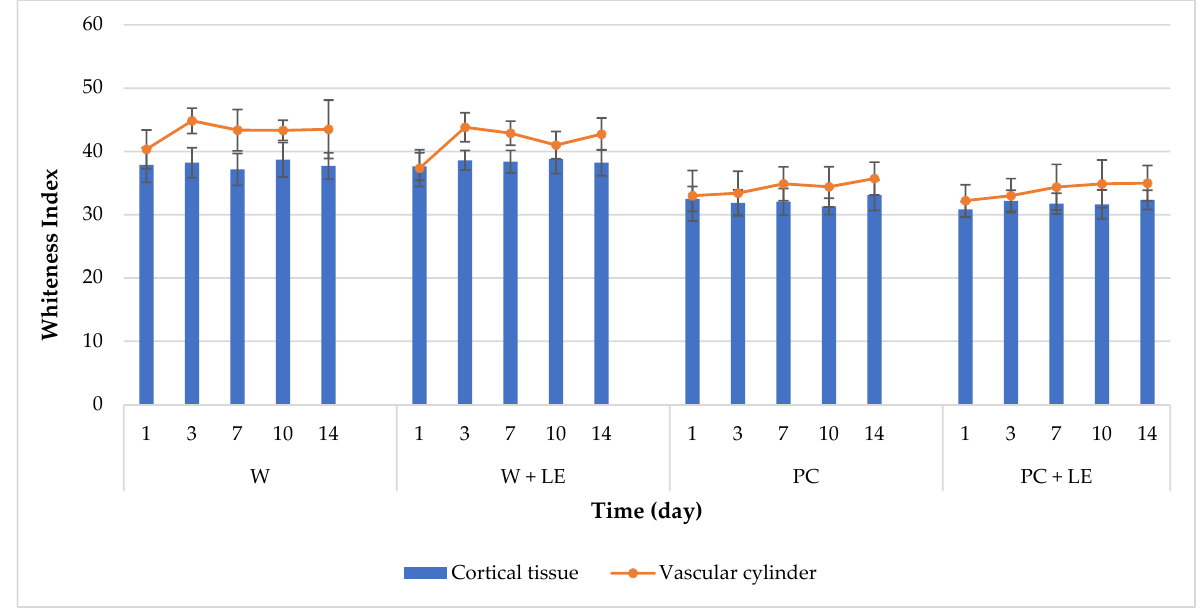
Figure 1. Changes in whiteness index (WI) values of uncoated and coated fresh-cut carrots on cortical tissue and vascular cylinder throughout 14 days of storage (4 °C). Abbreviations: W; W + LE; PC; PC + LE (see Table 1).